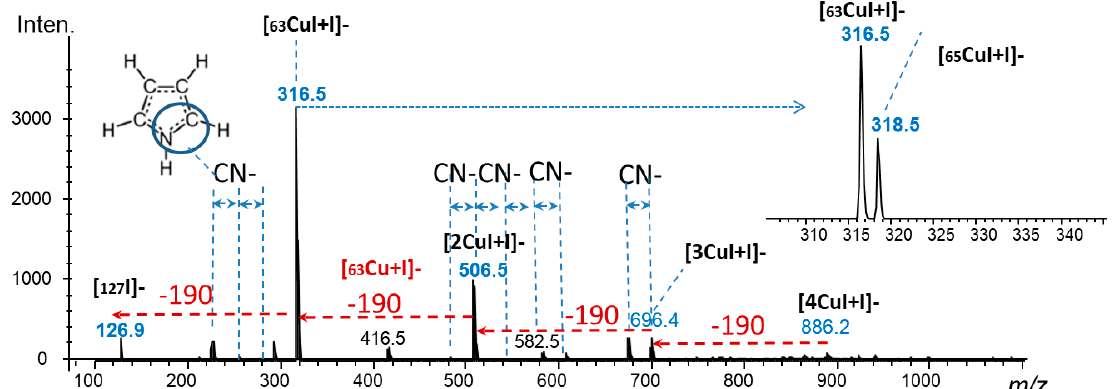
Figure 6. LDI–MS full scan recorded from CuI-PPy deposited by drop coating on the surface of SPE modified by TiO 2 -